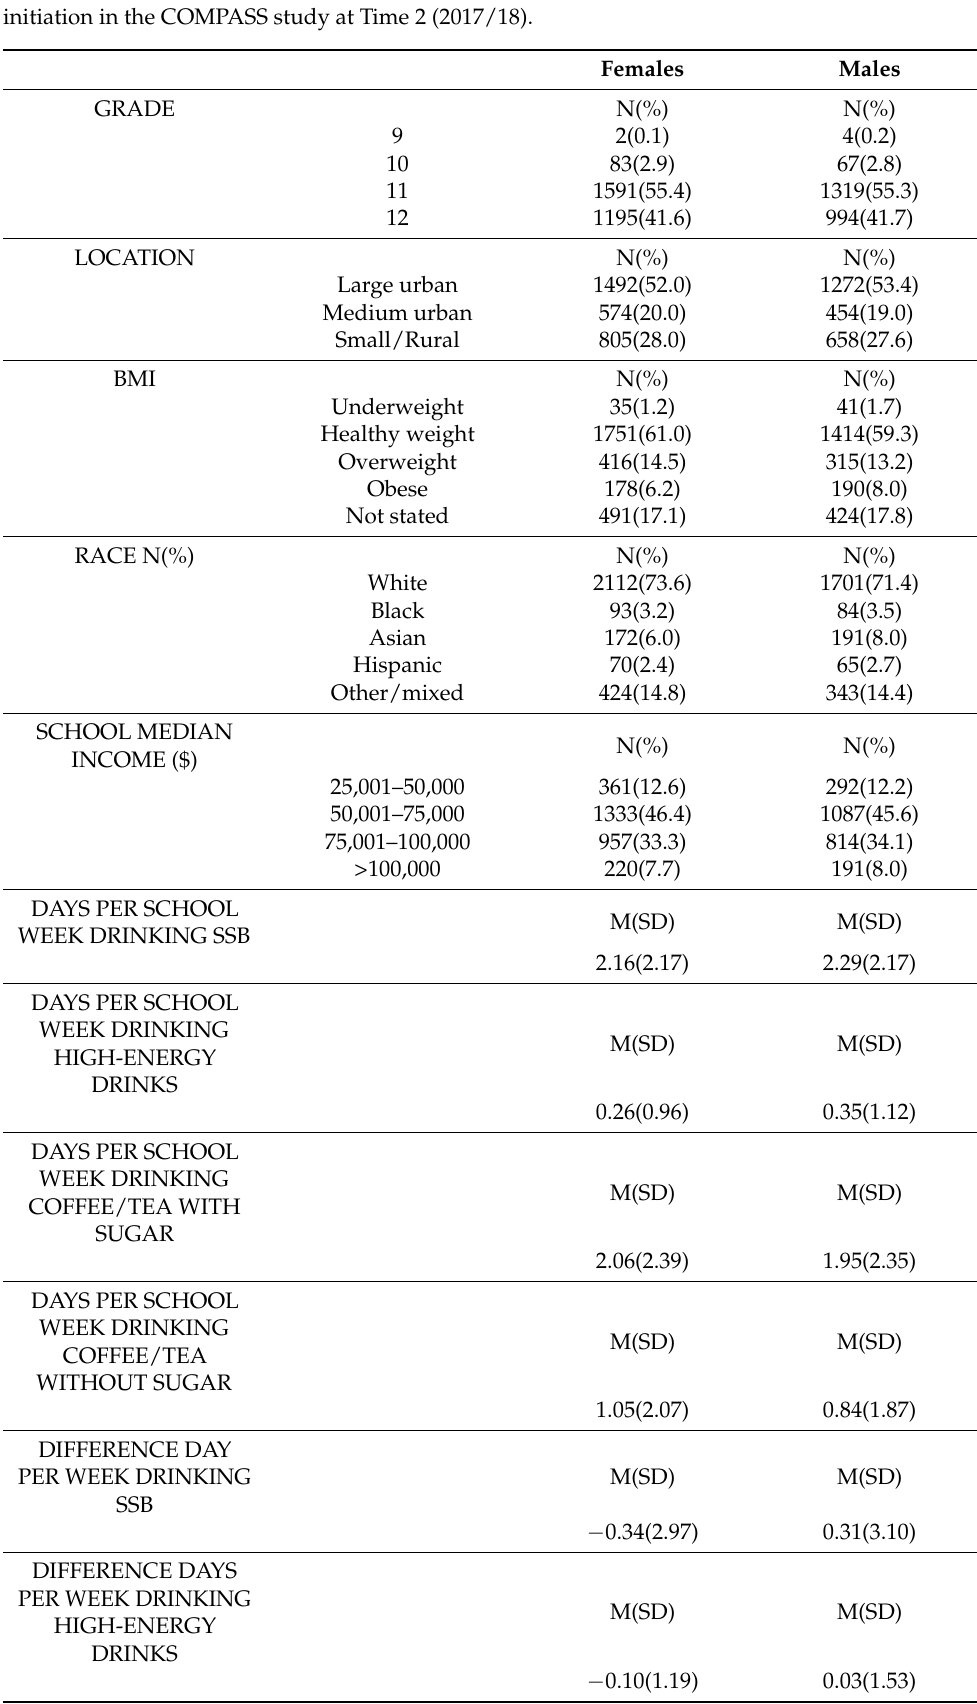
Table 3. Demographic and descriptive statistics of participants at Time 1 (2016/17) for vaping initiation in the COMPASS study at Time 2